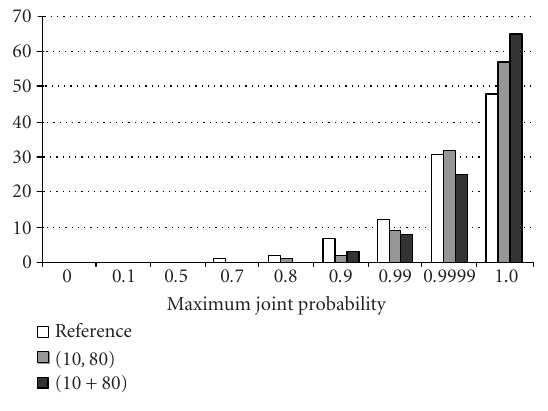
Figure 8: Histogram of OCR results.